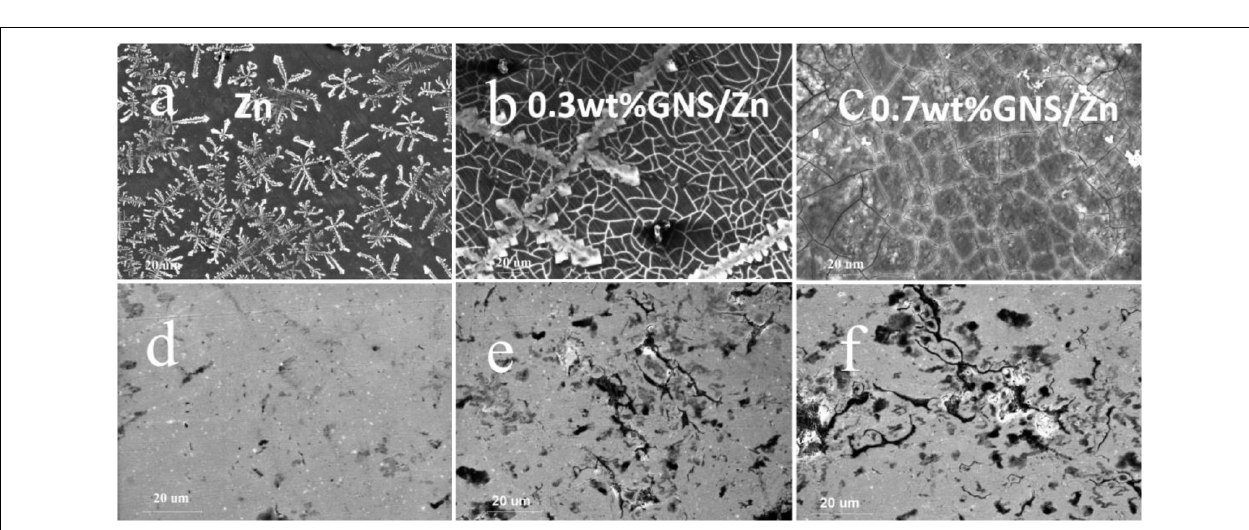
Frontiers in Bioengineering and Biotechnology |